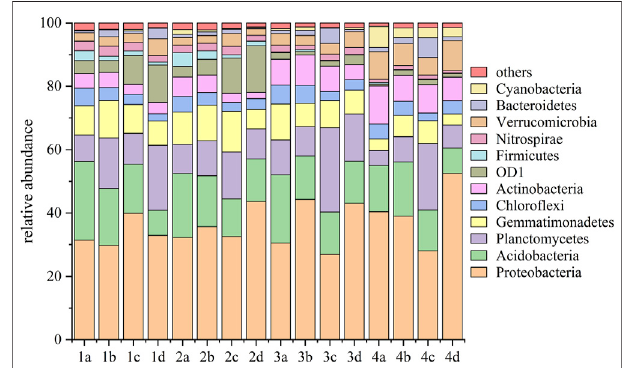
FIGURE 7 | Relative abundance (RA) of bacterial community structures based on the phylum levels of soils with various NMMT treatment amounts. Letters a, b, c, and d were marked 0%, 0.2%, 0.5%, and 1% NMMT added in contaminated soil,